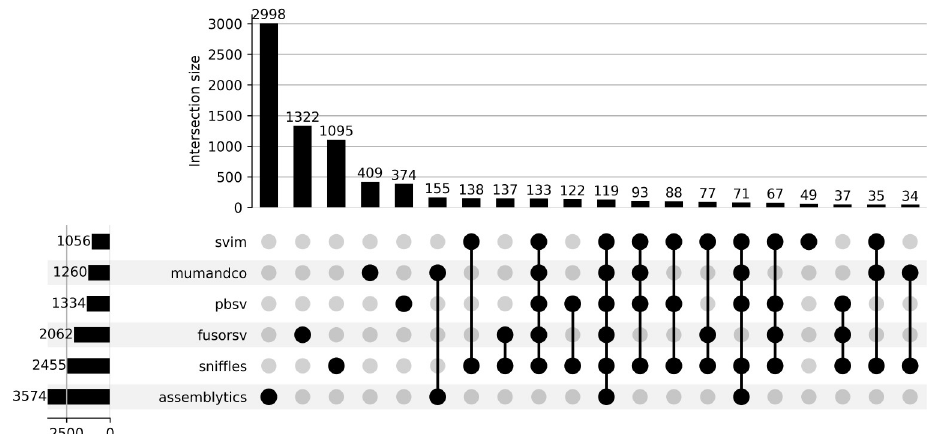
Fig 4. Caller agreement for deletions spanning protein-coding genes predicted from long-read tools and FusorSV. Each row represents the set of genes covered by deletions for a given caller. The columns depict the intersection of these predictions between callers. The plot is limited to the 20 largest sets.